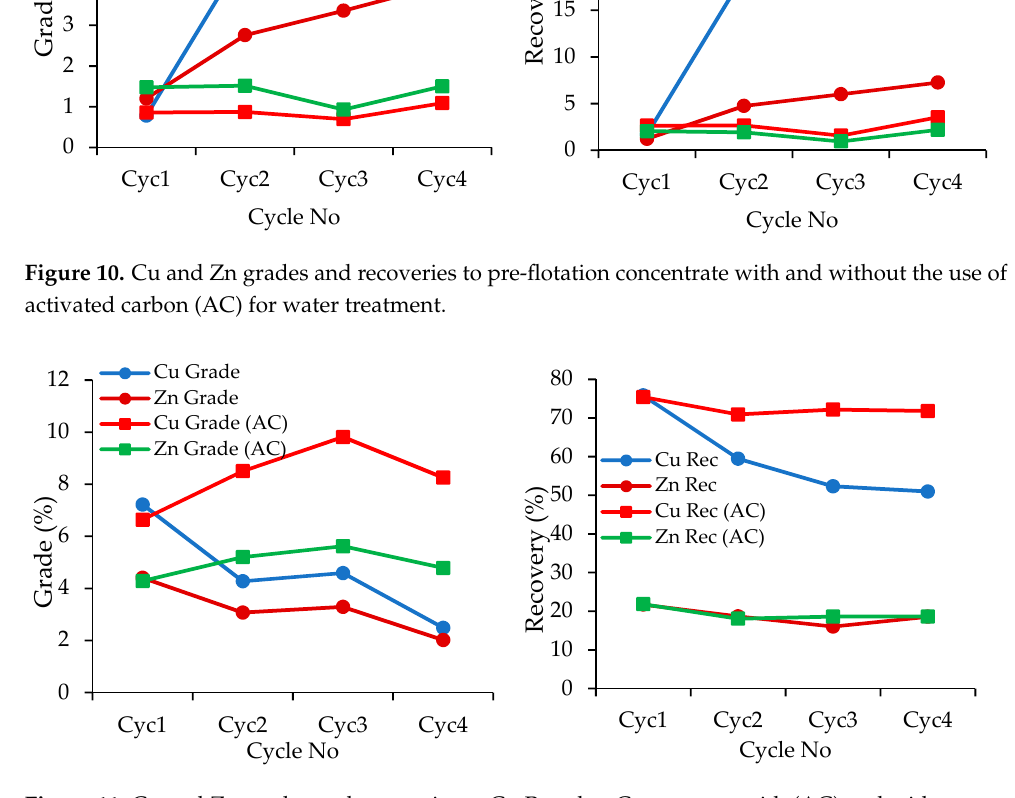
Figure 11. Cu and Zn grades and recoveries to Cu Rougher Concentrate with (AC) and without use of activated carbon for water treatment.